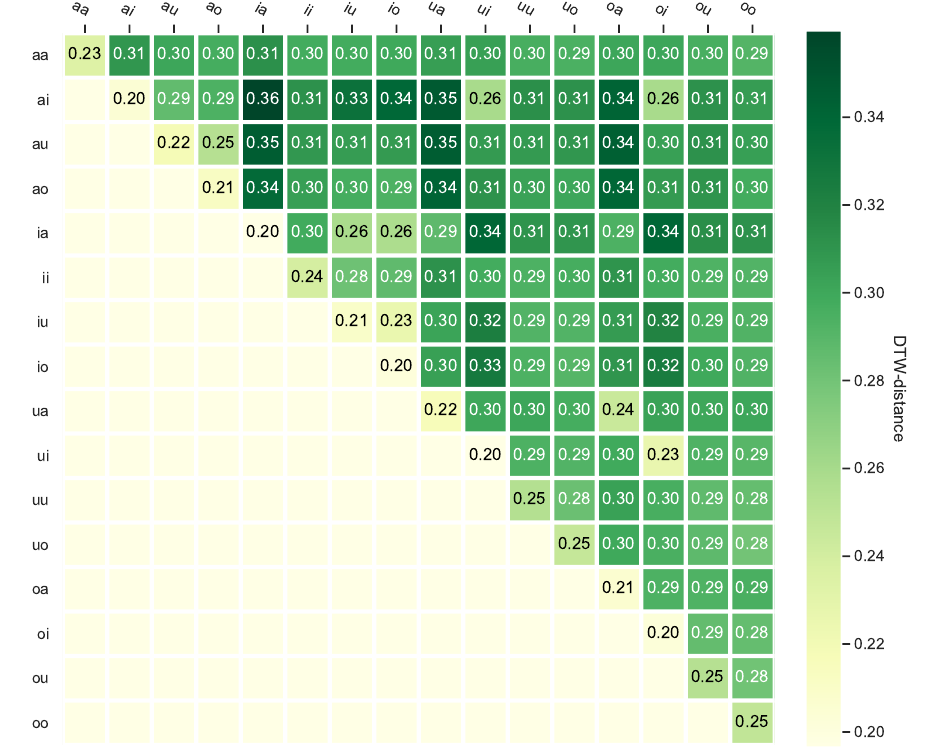
Figure A1. DTW mfcc calculated between samples from reference dataset. Lower values correspond to acoustically more similar samples.